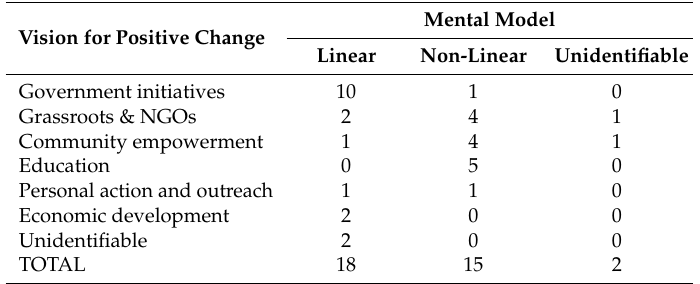
Table 5. Linear and non-linear thinkers and their visions for positive change. Vision for Positive